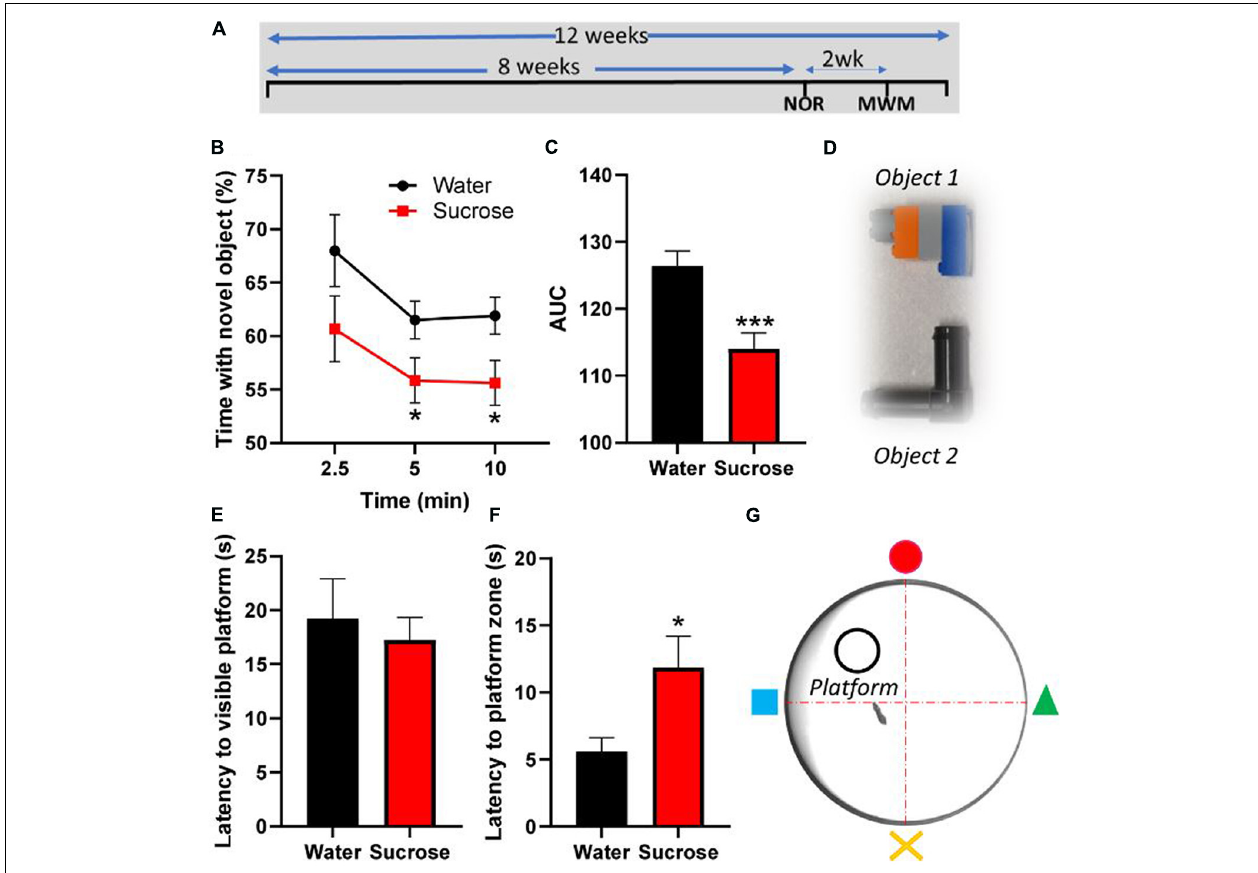
FIGURE 3 | Long-term sucrose consumption alters episodic and spatial memory. (A) Experimental design of the testing of episodic and spatial memory in the novel-object recognition (NOR) and Morris-watermaze (MWM) tests. Animals consumed 25% sucrose for 8 weeks prior to behavioral testing and continued to be exposed to sucrose for a total of 12 weeks. Memory tests were conducted 3 weeks apart. Animals were assigned into two groups: sugar-withdrawn animals and water controls. (B–D) Long-term sucrose drinking animals interact less with a novel object across the duration of the test, compared to water controls (B) , as confirmed by a reduction in the area-under-curve (AUC) (C) . The 2 objects used alternatively in the novel-object-recognition test, which are discernible in shape, size and color, are pictured in panel (D) . (E–G) Long-term sucrose consuming mice showed no alteration in their learning and swimming behavior to reach a visible platform (E) , however, they showed an increased latency to reach the zone where the platform was previously placed (F) compared to water controls. Schematic drawing of the MWM apparatus used is depicted in panel (G) . Data are presented as mean ± SEM; n = 8 mice/group. * p < 0.05, *** p < 0.001.